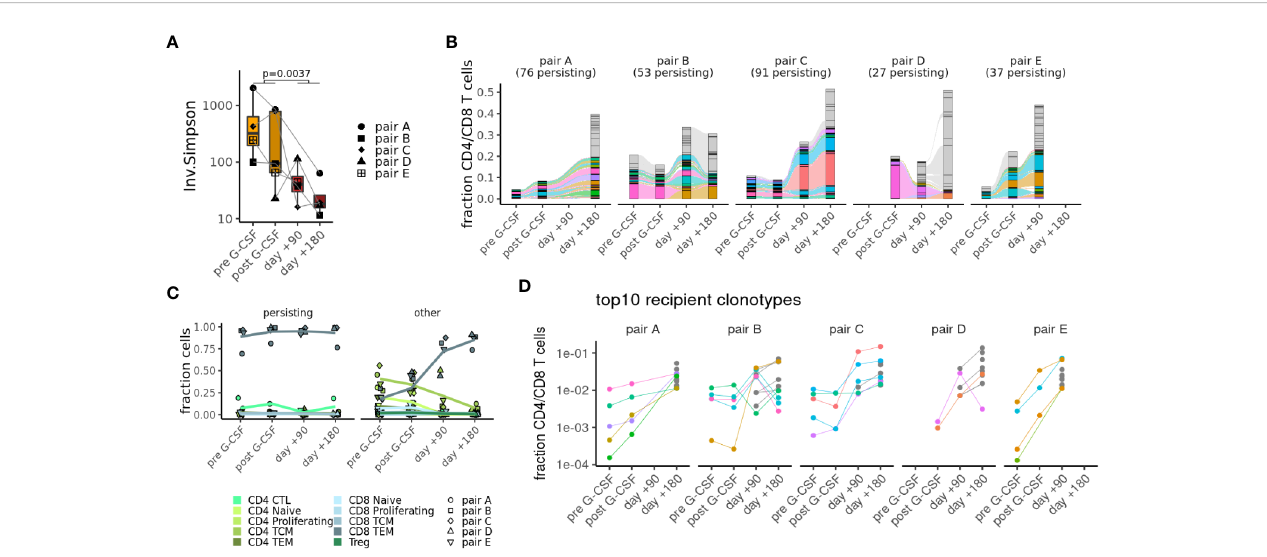
FIGURE 3 Clonal tracking of T-cells in alloHSCT. (A) Decrease in repertoire complexity from donors to recipients as measured by the inverse Simpson score. (B) Top clonotypes that are seen in both donor and recipient samples (colors) or else have > 1% abundance in any sample (gray). (C) Phenotypes of persisting clonotypes (seen in both donor and recipient samples) or other clonotypes at different time points. (D) Frequencies of top 10 recipient clonotypes shown at different time points for each